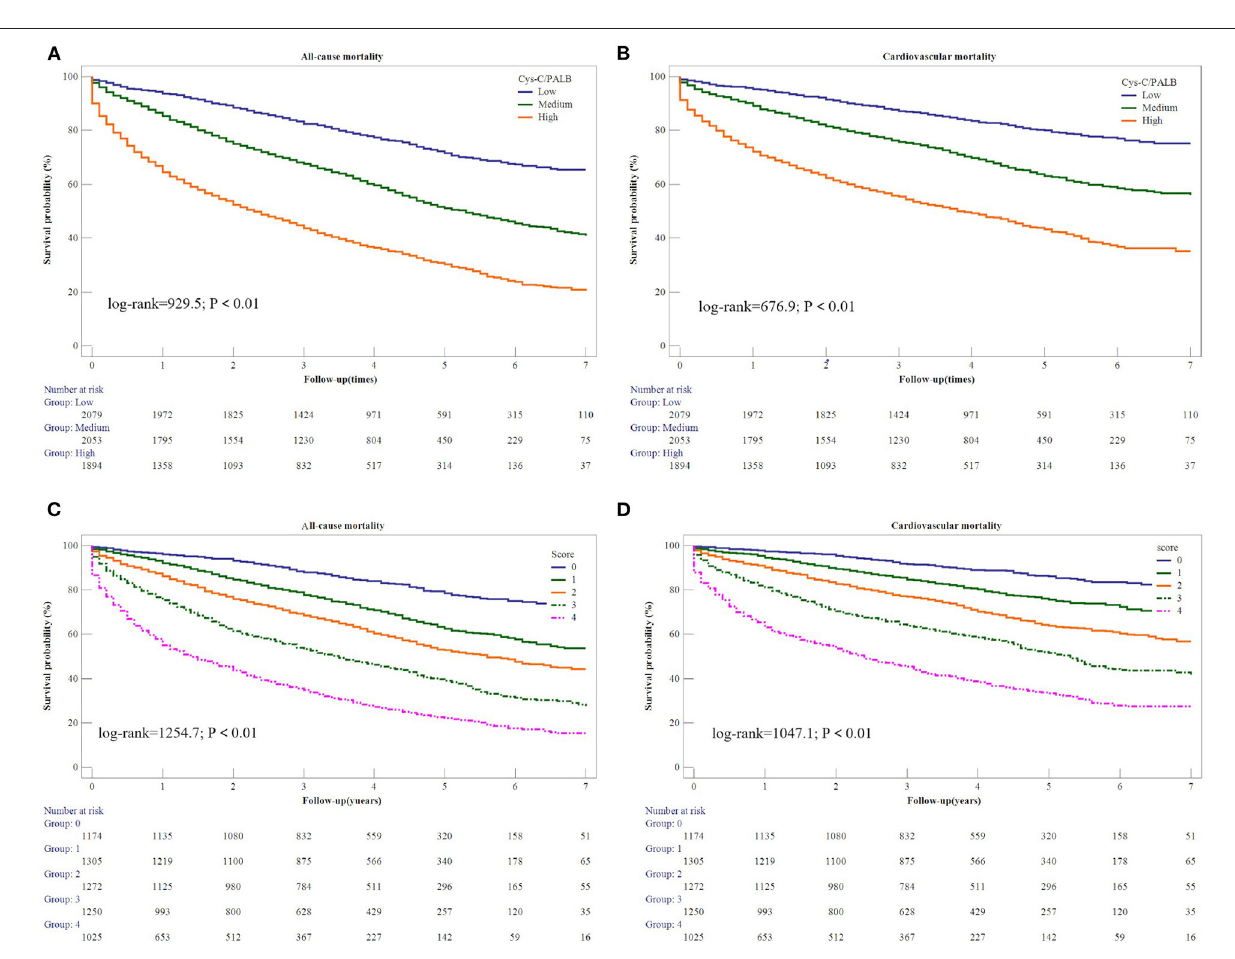
Frontiers in Cardiovascular Medicine |